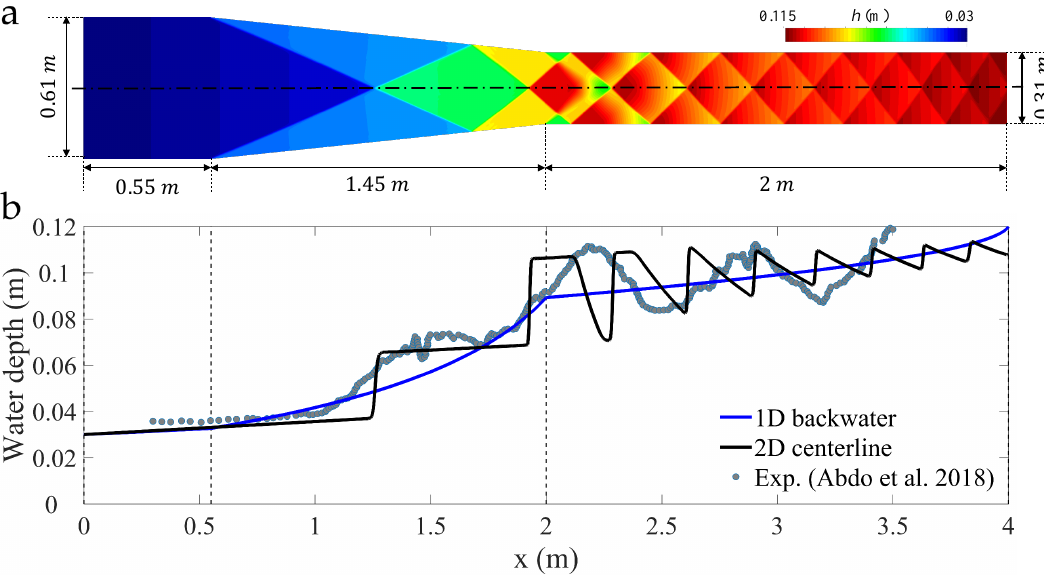
Figure 5. Model validation: supercritical flow in a channel contraction. ( a ) Schematic description of the flume geometry, according to the experiments of Ippen and Dawson [16], recently revisited by [44]. We show the steady-state water depth for a flow discharge Q = 0.041 m 3 /s, inlet water depth h = 0.03 m, and Manning friction coefficient n = 0.013. ( b ) Comparison between experimental observations of the water surface profile along the channel centerline [44], and model